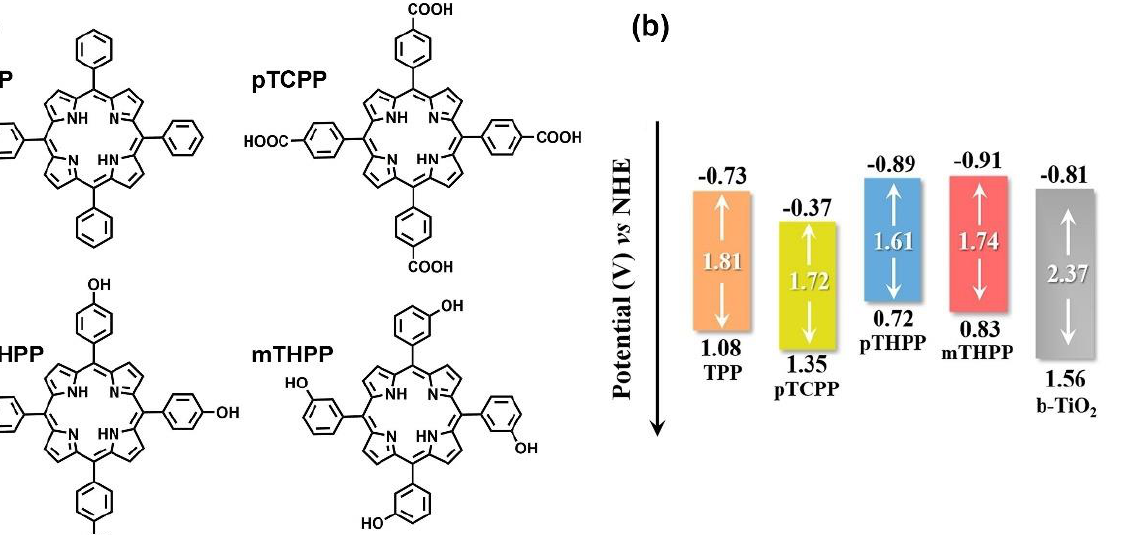
Figure 28. ( a ) Electron distribution and molecular dipoles in the four porphyrins studied (the direc- tion of the arrow represents the direction of the built-in electric field); ( b ) illustration of charge trans- fer for b-TiO 2 /29mTHPP (left) and b-TiO 2 /29pTCPP (right) under light. Reproduced from reference [104] with permission from Elsevier, copyright 2022.